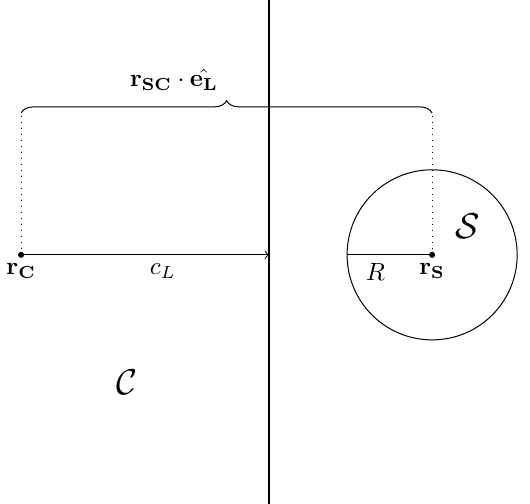
and a cuboid at relative distance r SC S C